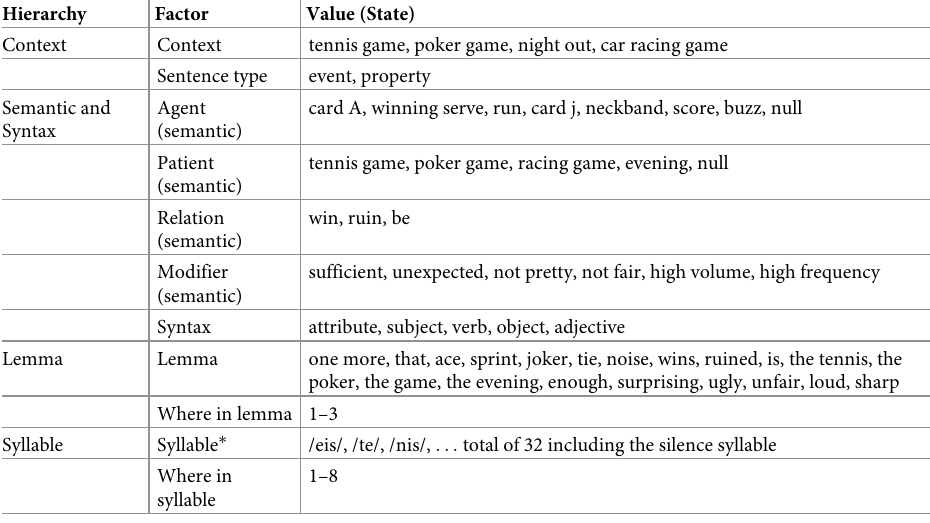
Table 1. Factors and their possible values (states) in the model